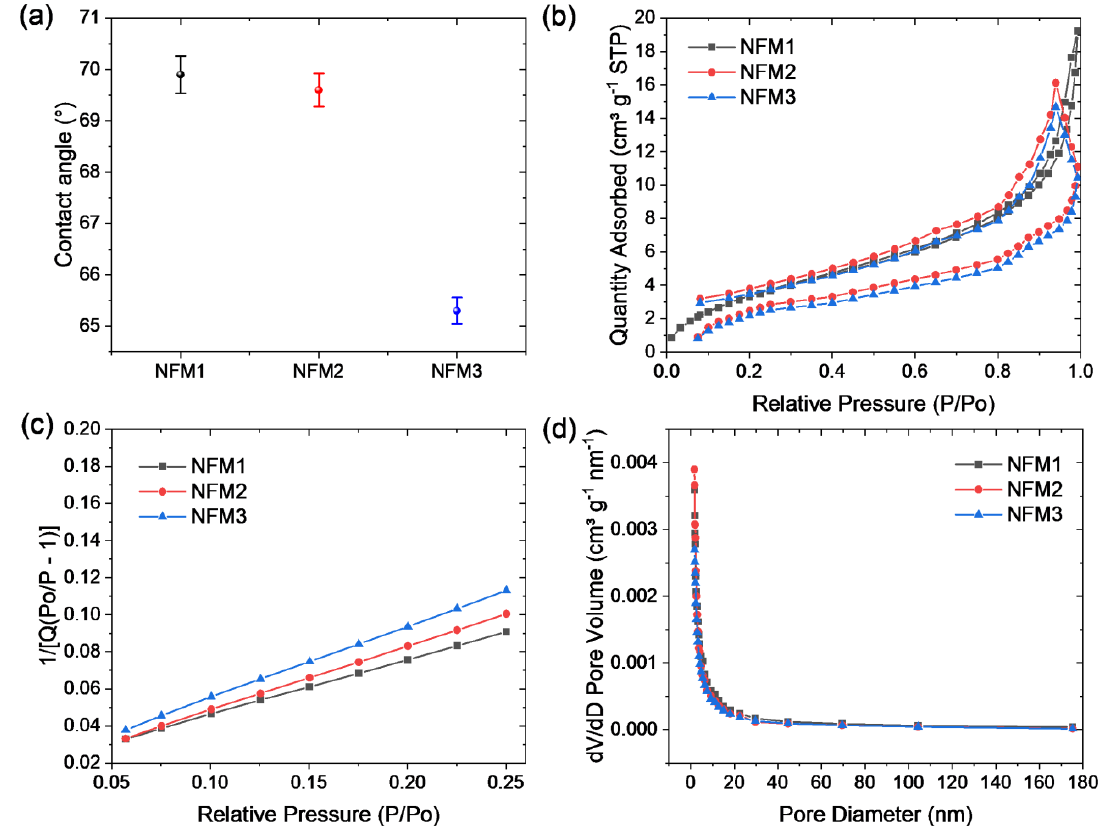
Figure 3. ( a ) Average water contact angles of PNI-SBMA/PVA NFMs in different proportions, ( b ) nitrogen adsorption isotherms of PNI-SBMA/PVA NFMs, ( c ) the linear plots of the corresponding Brunauer-Emmett-Teller (BET) surface areas of PNI-SBMA/PVA NFMs, and ( d ) pore size distributions of PNI-SBMA/PVA NFMs.